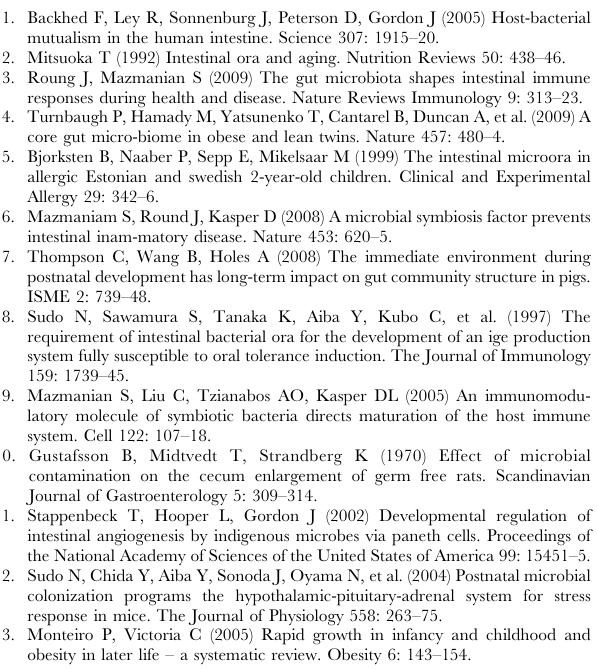
Created statistical method used in analysis: RAW DDB SDP ME. Conceived and designed the experiments: ME. Performed the